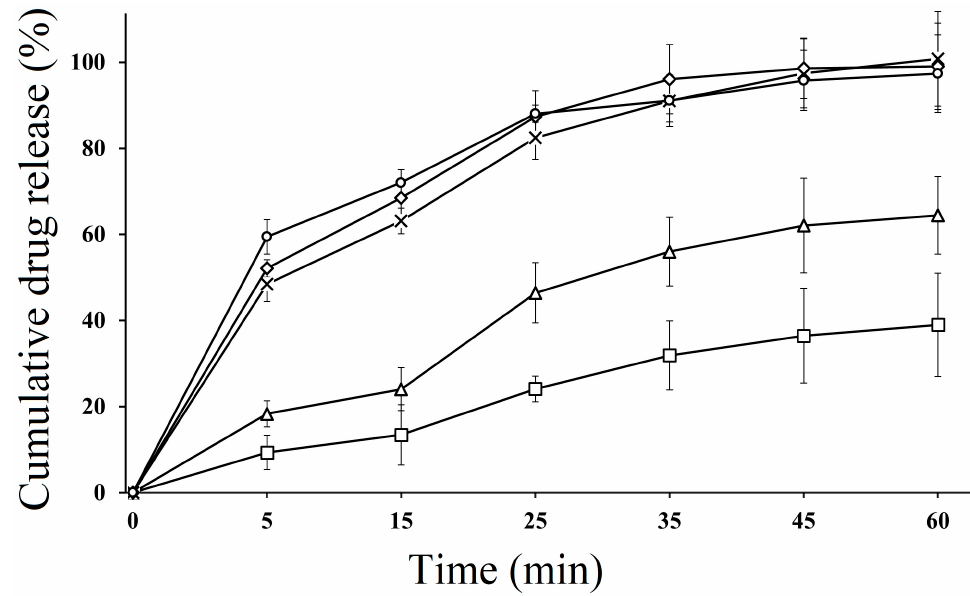
Figure 3. In vitro dissolution study of pure CFX P1 ( □ ), marketed CFX suspension F5 ( ∆ ) CFX from oily droplets F2 ( ), F3 ( × ) and F4 ( ♦ ) in SGF (0.1 N HCL, pH 1.2) at 37 ◦ C for 60 min. Data are presented as means ( n = 3) ± SD.